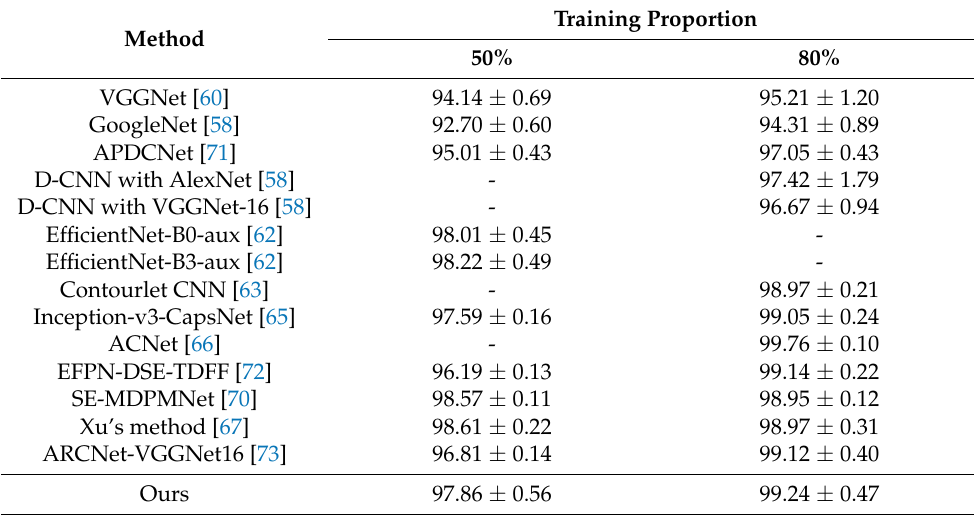
Table 6. Classification accuracy on the UCM dataset compared to CNN-based models (OA ±